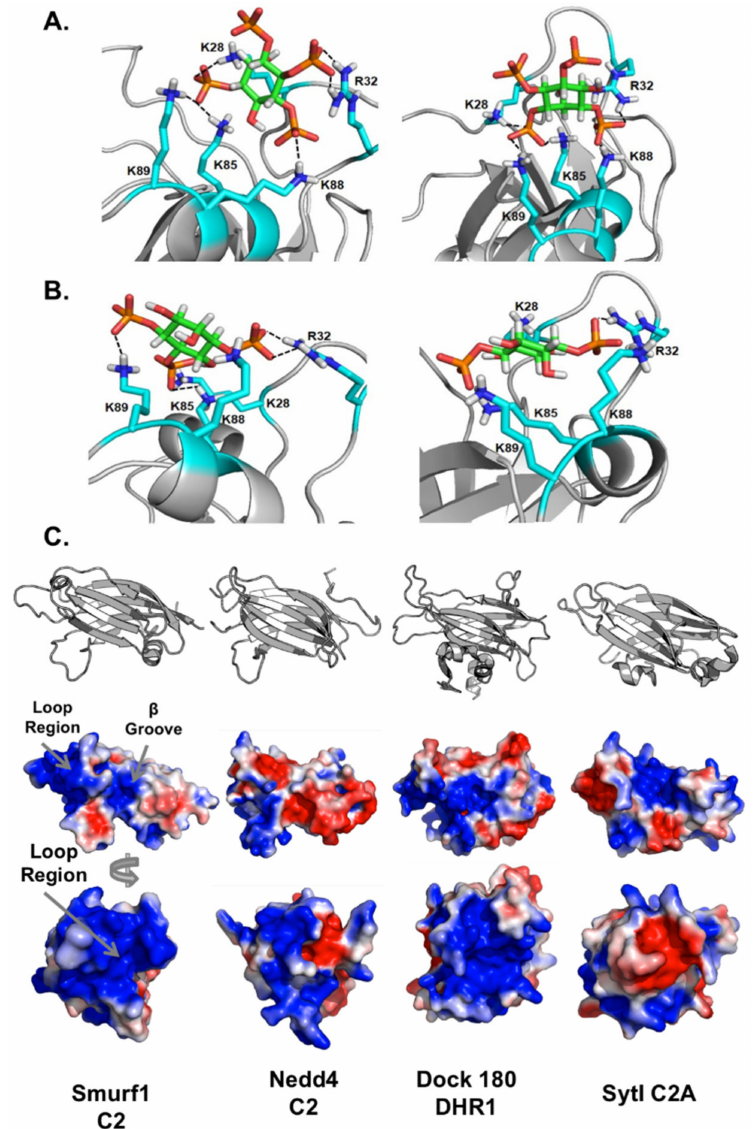
Figure9. MoleculardynamicsandinositolphosphatedockingrevealspotentialPIPcoordinationmechanisms fortheSmurf1C2domain. ( A )TheSmurf1C2domainisshowndockedwithinositol(1,3,4,5)P 4 indicating potential interactions between R32 and the 4-phosphate, K28, K85 and K89 with the 1-phosphate, and K88 with the 5-phosphate (left panel). The right panel shows a second possible orientation, with R32 and K88 interacting with the 1-phosphate, K28, K85 and K89 interacting with the 3-phosphate, and the 4-phosphate and 5-phosphate exposed to the solvent. ( B ) In the left panel, the Smurf1 C2 domain is shown with a potential binding orientation of inositol(1,4,5)P 3 . Here, R32 and K88 interact with 1-phosphate whereas K89 interacts with 4-phosphate, and K28 and K85 interact with 5-phospate. The right panel shows a docking orientation of the Smurf1 C2 domain and inositol(1,4)P 2 , where R32 and K88 interact with 1-phosphate, K85 and K89 interact with 4-phosphate, and K28 interacts with the 6-hydroxyl group ( C ) The top panel shows the overall structure of Smurf1 C2 (charge ~ + 9), Nedd4-1 C2 (charge ~ + 1), DOCK180 DHR1 C2-like (charge ~ − 1), and synaptotagmin I C2A (charge ~ + 2) to compare potential loop and β -groove PIP binding mechanisms (PDB IDs: Smurf1 C2 = 3PYC, Nedd4 C2 = 2NSQ, Dock180 C2 = 3L4C, Syt1C2A = 3GPE). The electrostatic solvent-accessible surface of the C2 domains was generated using the Mac Pymol APBS plugin. The side of the C2 domain with the canonical cationic patch is represented in cartoon form and with the electrostatic surface (middle panel) and the C2 domains were then rotated 90 ◦ to the right on the horizontal axis to observe the protein from the loop region (bottom